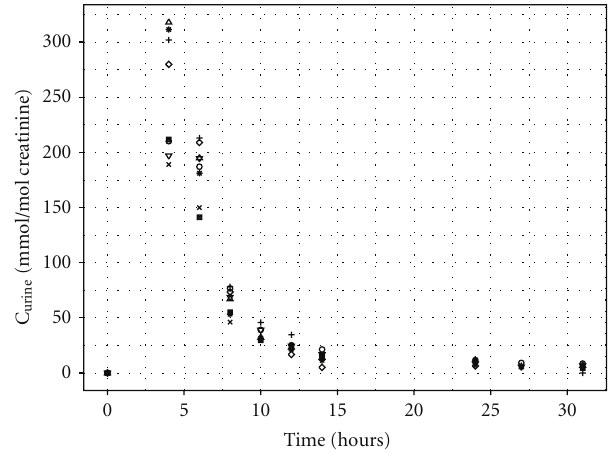
Figure 3: Urinary 3-methylhippuric acid (MHA). Urinary excre- tion of MHA expressed against creatinine for eight volunteers used in reverse